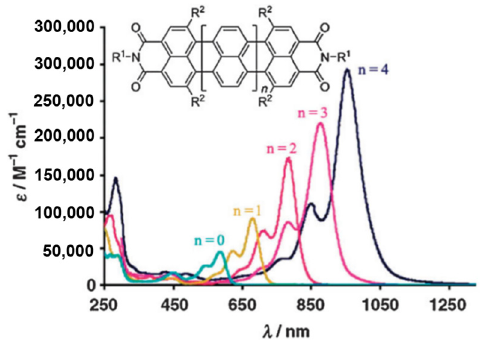
Figure 2. Absorption spectra of the entire tetraphenoxy-substituted rylenediimide series in CHCl 3 (adapted from ref. [65]).